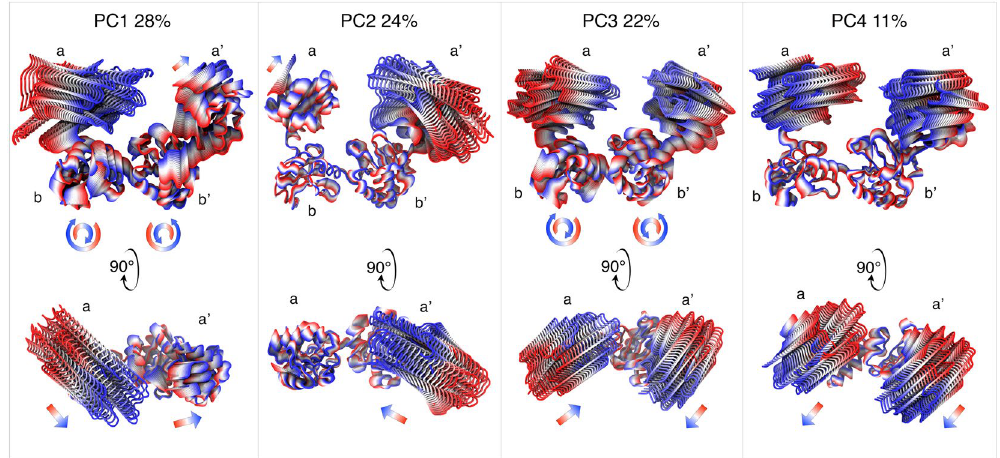
Figure 3. hPDI domain motion modes from PC1, PC2, PC3 and PC4 represented the dominant